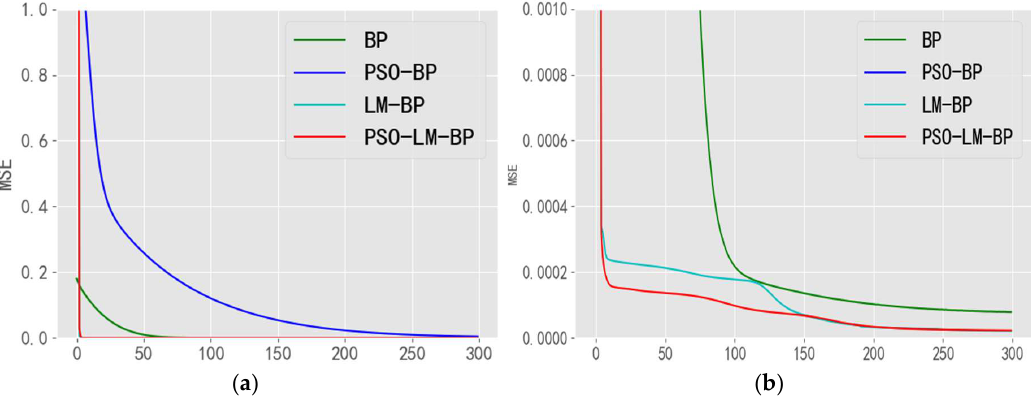
Figure 10. The mean square error values of the training process of the four algorithms. ( a ) The algorithm iterates the overall icon; ( b ) Enlarged local representation.